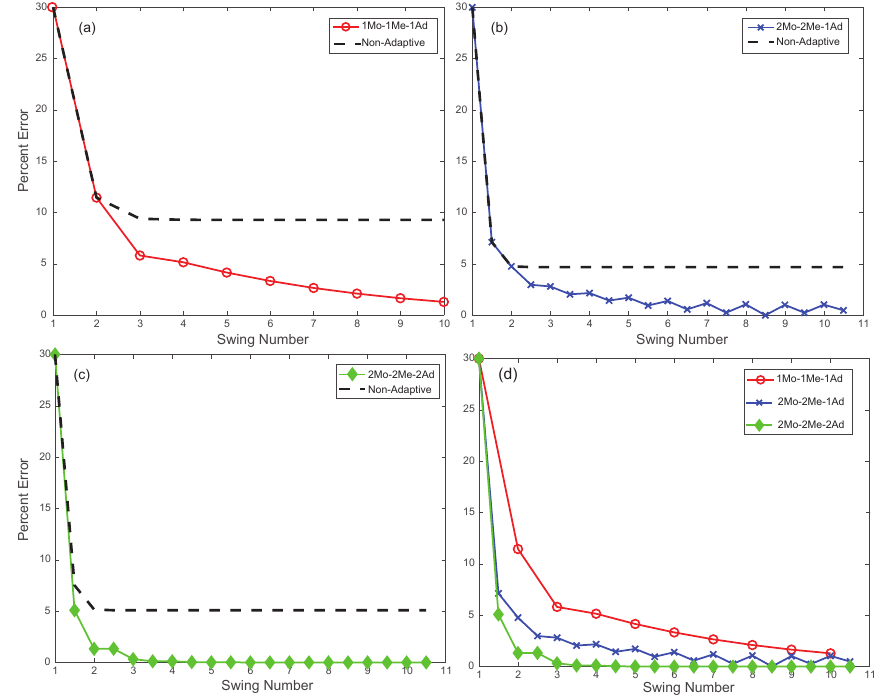
Figure 4. Comparison of adaptive to non-adaptive control: ( a ) 1Mo-1Me-1Ad, ( b ) 2Mo-2Me- 1Ad, ( c ) 2Mo-2Me-2Ad, and ( d ) all adaptive controllers, where Mo is the number of models per swing, Me is the number of measurements per swing, and Ad is the number of adaptations per model.